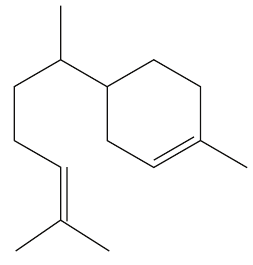
Figure 4: Structure of β -bisabolene.